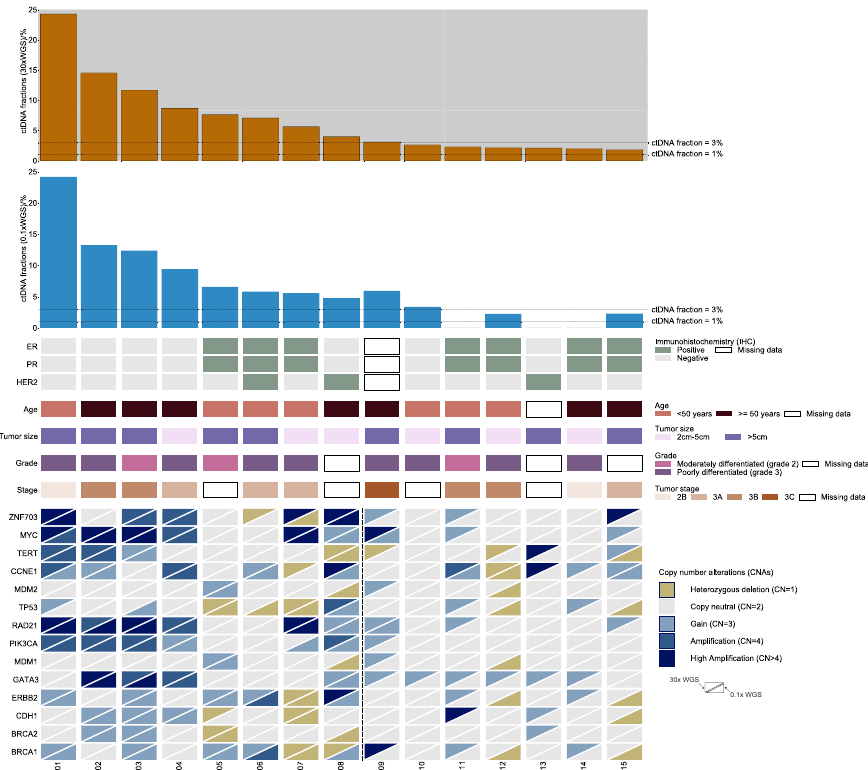
Fig. 1 Co-mutation plot showing association between clinical information and genomic characteristics. Patients are represented by the columns ordered by decreasing ctDNA fraction. The top two rows show bar plots of tumor fractions estimated with ichorCNA from cfDNA sequenced with 30× WGS-cfDNA (gold bars) and 0.1× WGS-cfDNA (blue bars) ( n = 15 patients). The horizontal line across the bar plot shows the limit of detection of ichorCNA for 0.1× (ctDNA fraction = 3%) and a threshold for 30x (ctDNA fraction = 1%) for the detection of ctDNA. Immunohistochemical stains for ER, PR and HER2 + , age, and tumor size classi fi cation are presented. Copy number gain and loss of selected driver genes in breast cancers are shown in the bottom